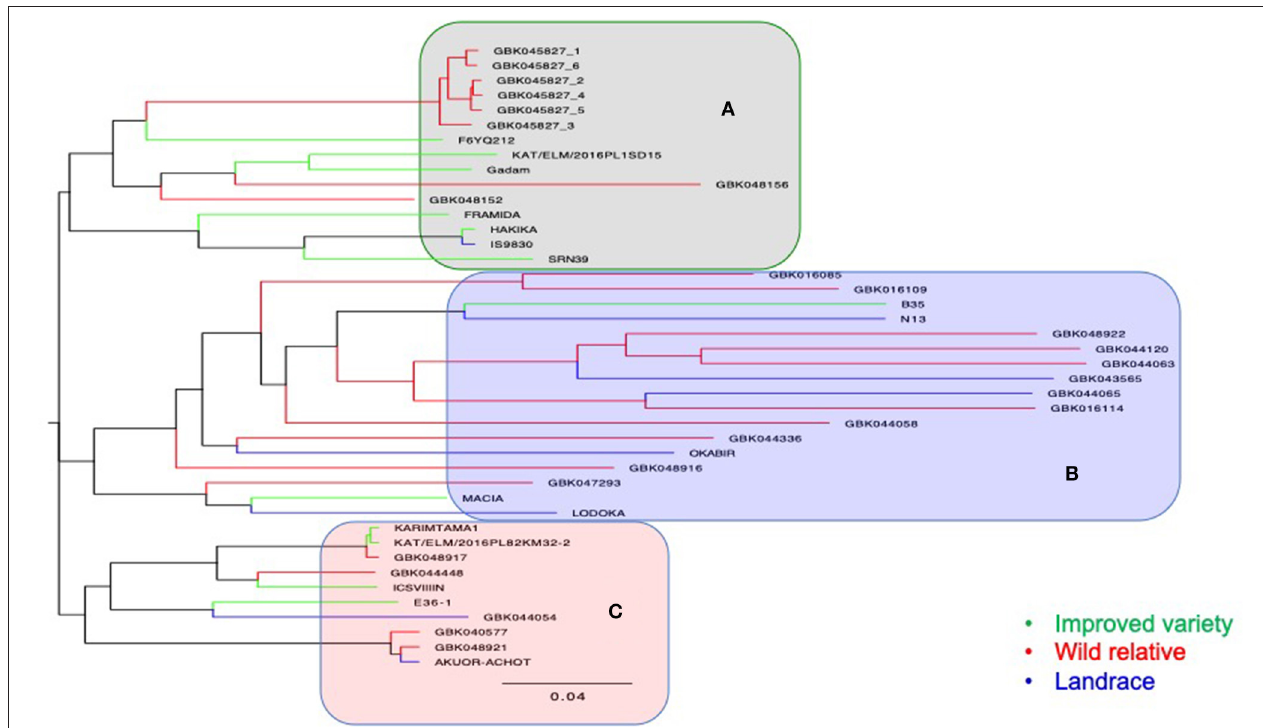
FIGURE 5 | A neighbor-joining dendrogram showing genetic relatedness of 37 accessions that comprised of 17 wild accessions, 8 landraces, and 12 improved varieties. The main clusters generated are highlighted in gray (A) , light blue (B) , and pink (C) .